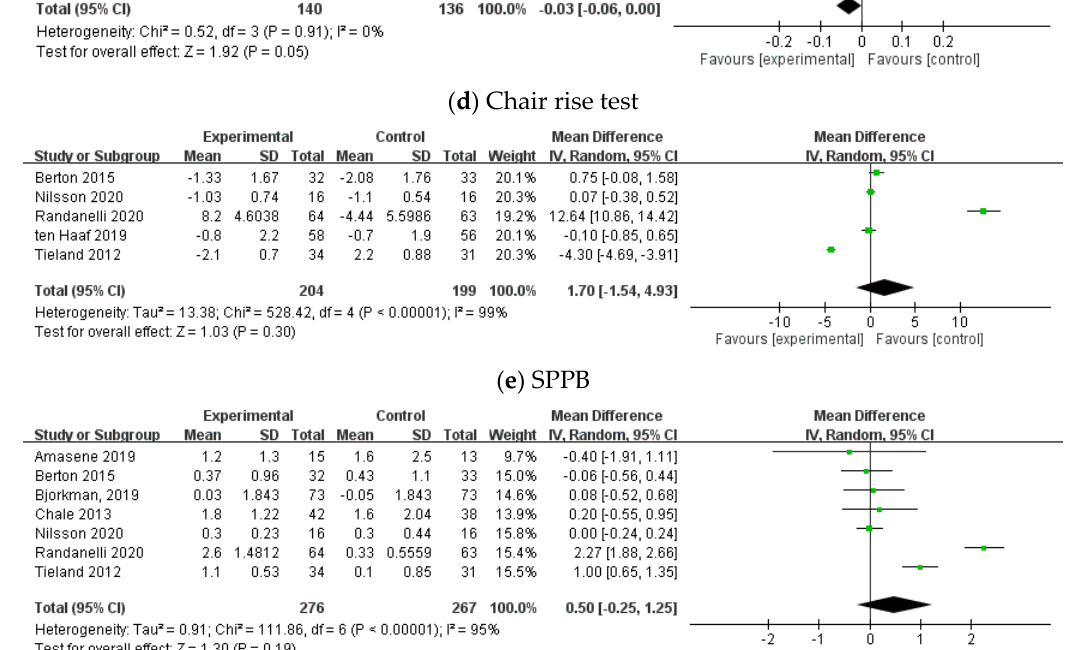
Figure 3. Forest plot of the effect of protein intake on ( a ) muscle mass: skeletal muscle mass index, ( b ) muscle strength: hand grip strength, physical performance: ( c ) 4 m gait speed, ( d ) chair rise test, and ( e ) short physical performance battery (SPPB) in randomized clinical trials.